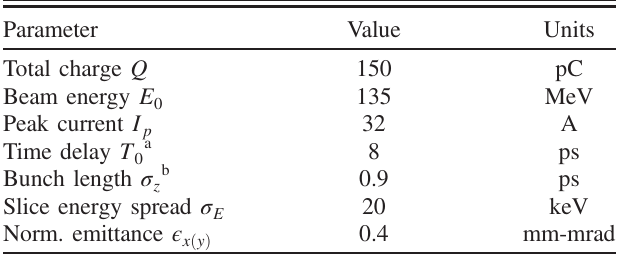
TABLE I. Beam parameters of the twin bunches after the injector.